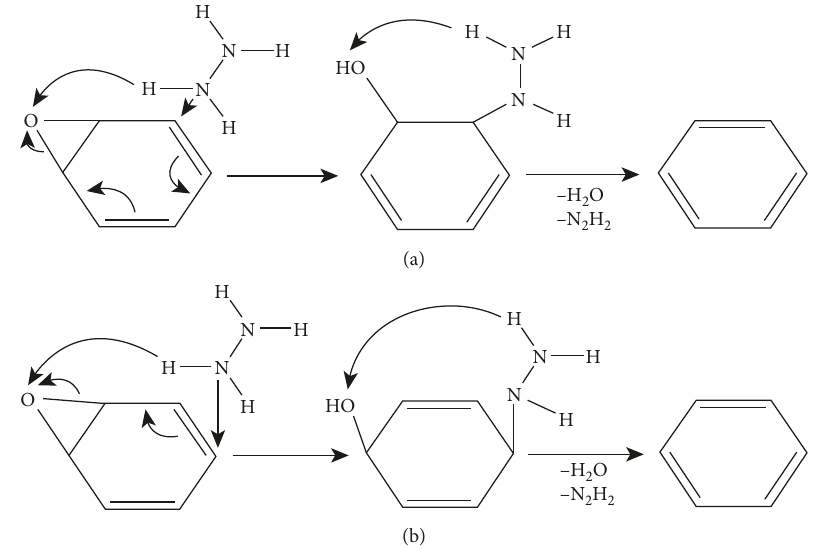
Figure 15: Reaction mechanisms for the chemical reduction of graphene oxide with hydrazine.